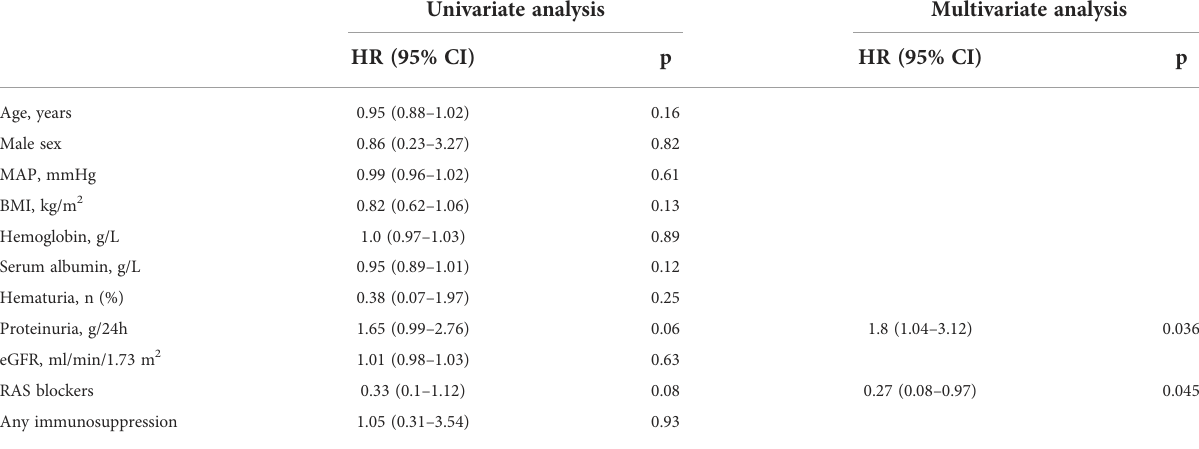
TABLE 2 Univariate and multivariate Cox analyses of clinical parameters predicting the progression of mesangial lesions in IgA nephropathy. Univariate